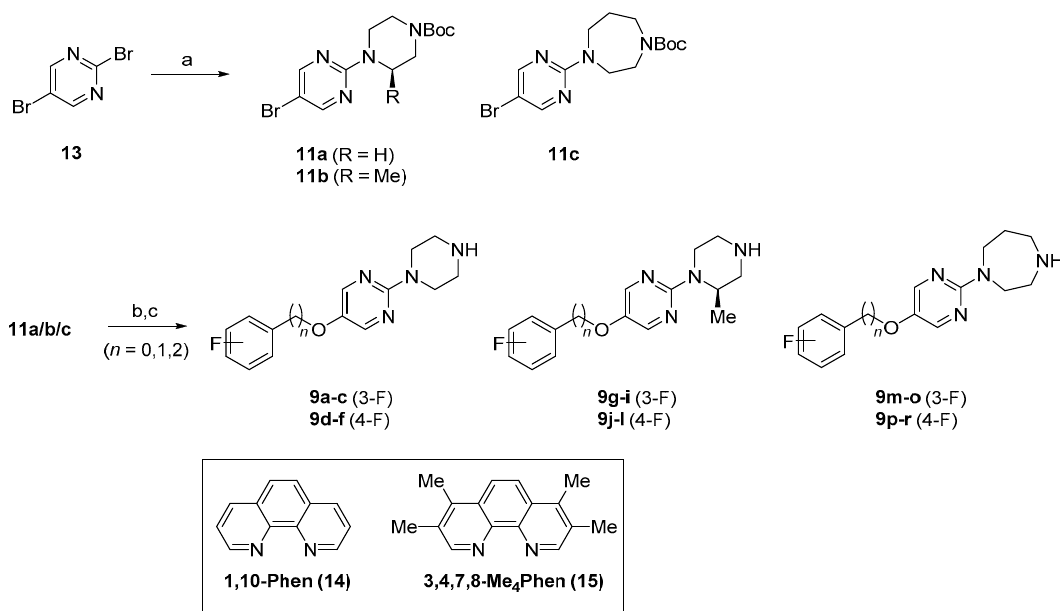
Figure 2. Design of new pyrimidine derivatives as 5-HT 2C